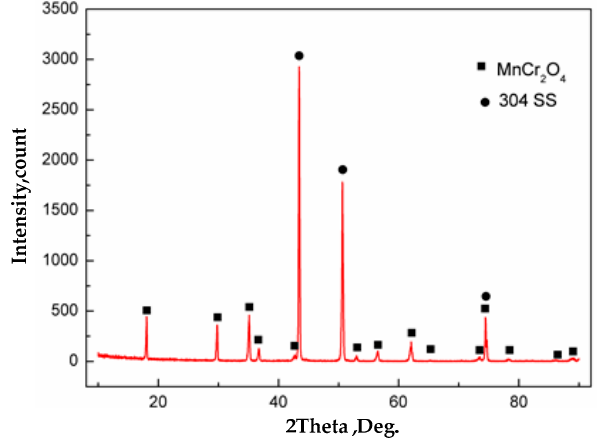
Figure 13. Phase analysis by X-ray diffraction of stainless steel surface after heating in vacuum of 10 5 Pa.